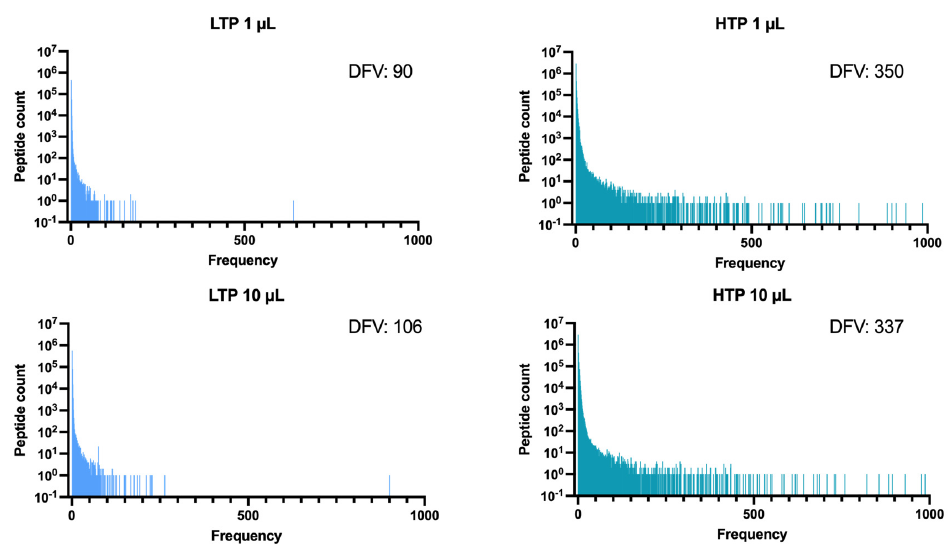
Figure 2. The distribution of absolute frequencies for each sample. For each dataset LTP (1 µ L and 10 µ L) and HTP (1 µ L and 10 µ L), the number of peptides with absolute frequencies from 1 to >1000 was identified. The number of distinct frequency values (DFVs) were counted for each sample.